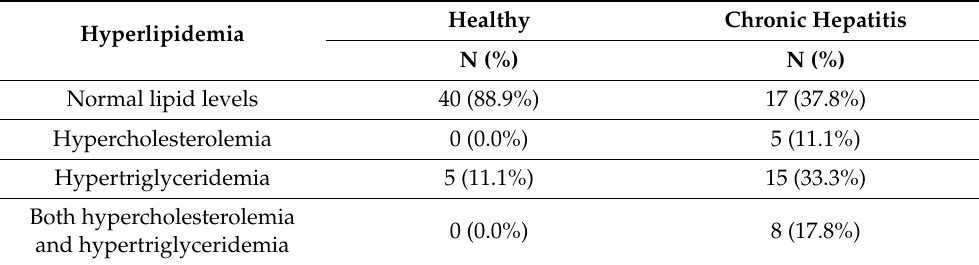
Table 2. Hyperlipidemia, as determined by the elevation of lipids (triglyceride > 108 mg/dL or cholesterol > 335 mg/dL), in healthy dogs and dogs with chronic